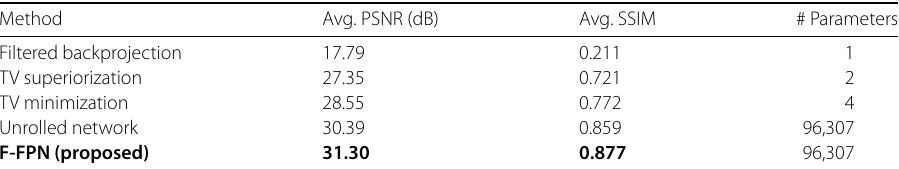
Table 1 Average PSNR and SSIM on the 1000 image ellipse testing dataset.